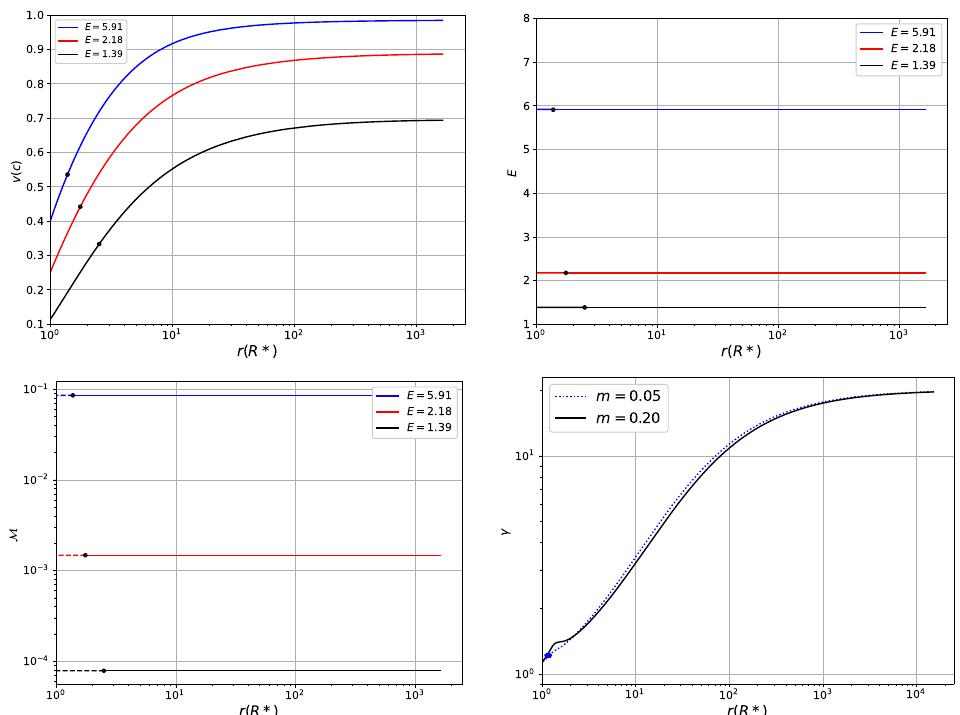
Figure 4. ( Top left ): Velocity profiles associated with Figure 3 for case m = 0 choosing different values of E = 5.91 (blue), 2.18 (red), 1.39 (black); Establishing the invariance of the constants of motion E ( top right ) and ˙ M ( bottom left ) along radial coordinate r for solutions in Figure 3. ( Bottom right ): Lorentz factor profiles for the choices of smaller values of m = 0.05 and 0.2 choosing E = 20. Points with black open circles and blue filled stars denote the locations of sonic points as in Figure 3. For all panels above, ξ = 0.1.